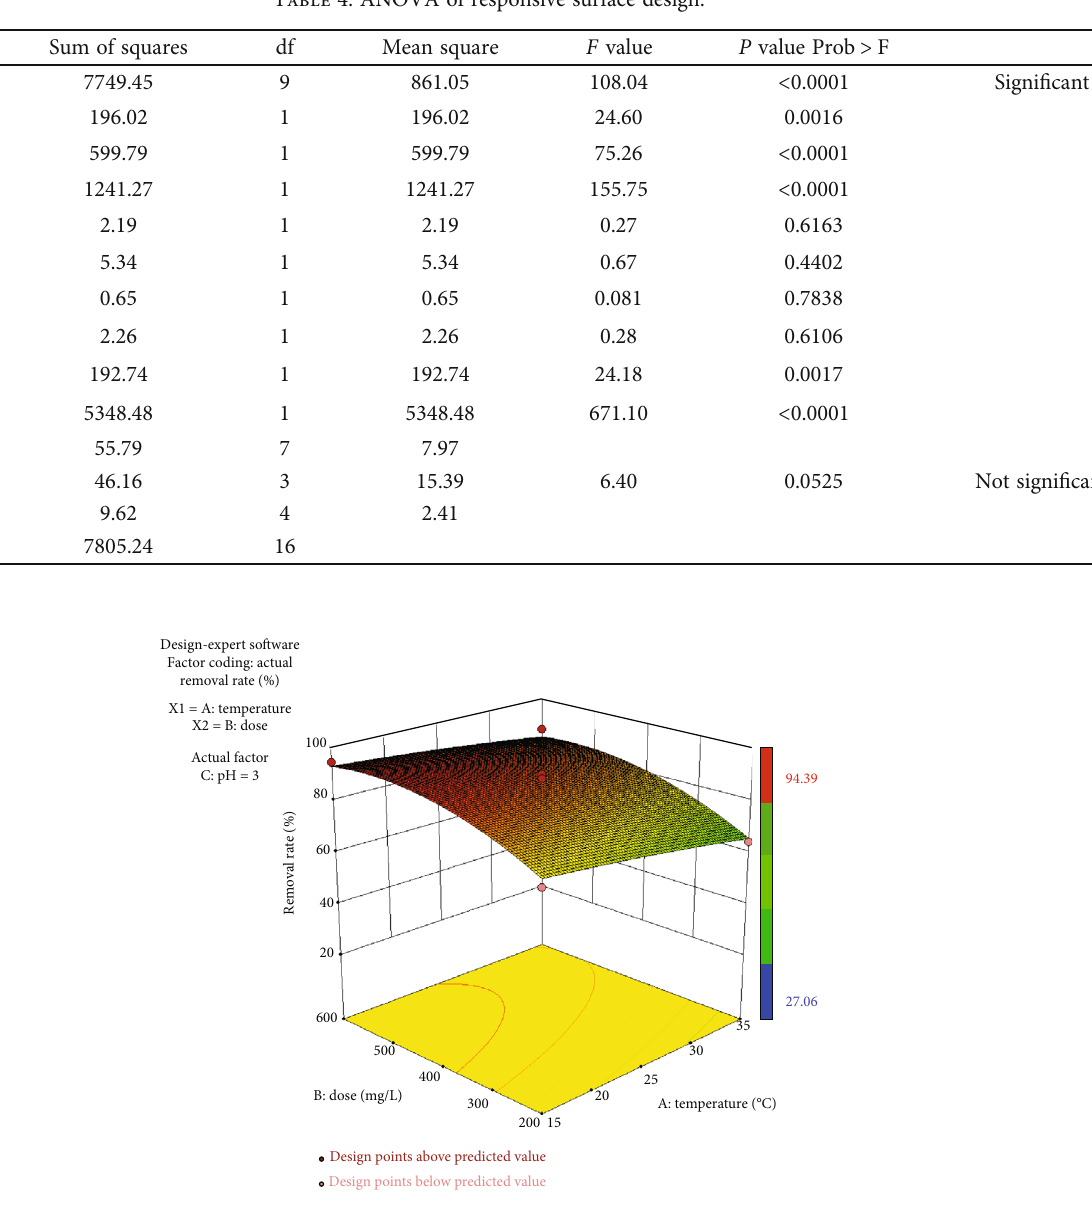
Table 4: ANOVA of responsive surface design.